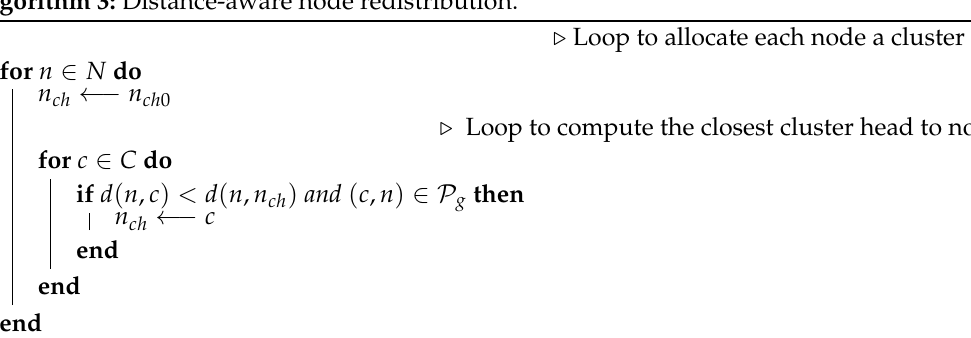
Algorithm 3: Distance-aware node